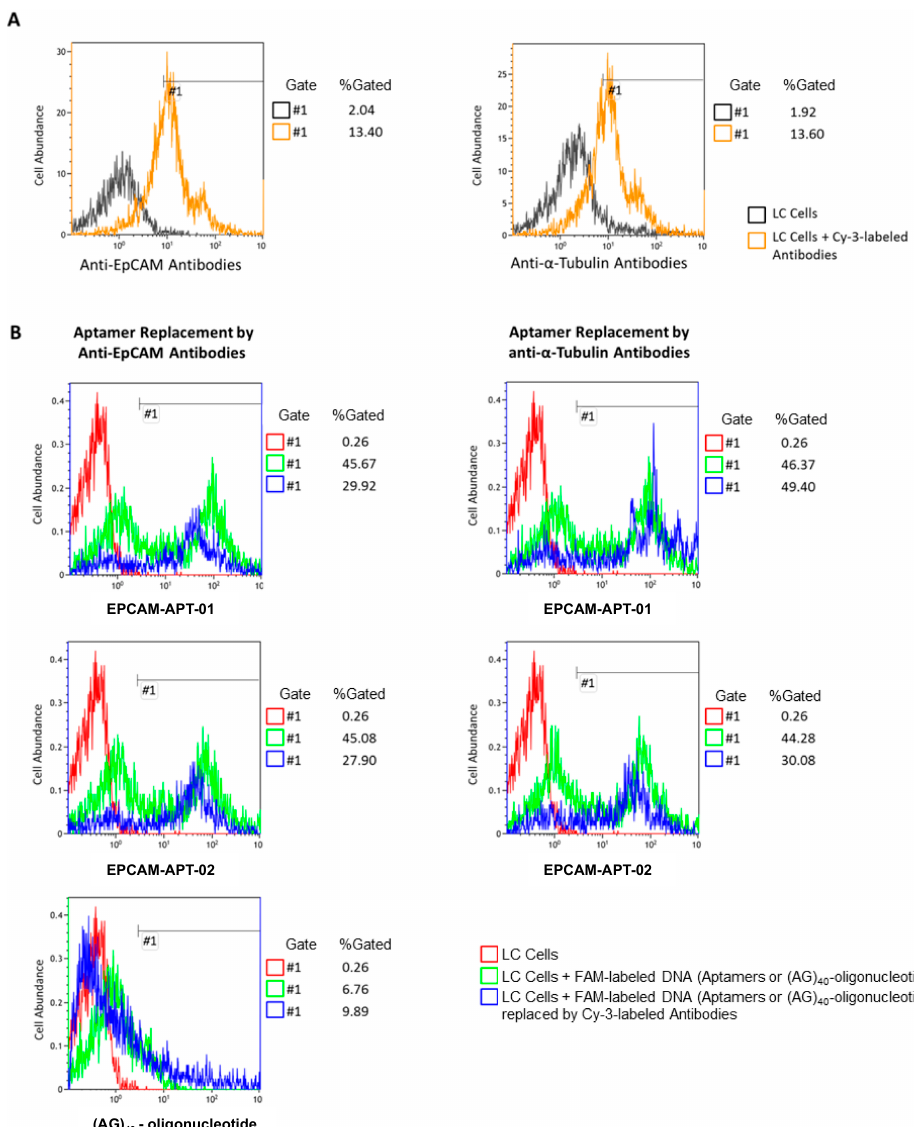
Figure 3. Competitive displacement of aptamers with antibodies. ( A ) Flow cytometry of LC cells and LC cells preincubated with Cy-3 labeled anti-EpCAM or anti- α -Tubulin antibodies. ( B ) Flow cytometry of LC cells (red), LC cells preincubated with 6-carboxyfluorescein (FAM)-labeled EPCAM-APT-01, EPCAM-APT-02 or oligonucleotide (AG) 40 before (green) and after (blue) replacement by Cy-3 labeled anti-EpCAM or anti- α -Tubulin antibodies. Aptamer EPCAM-APT-02 also showed specificity to EpCAM as nearly 18% of LC cells released the aptamer from the surface after replacement by anti-EpCAM antibodies (Figure 3B).